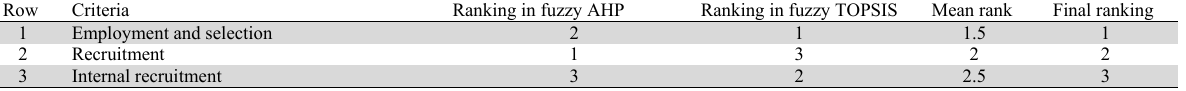
The results of final ranking of main HRM sub-criteria Row Criteria Ranking in fuzzy AHP Ranking in fuzzy TOPSIS Mean rank Forecasting how to match HR demand and supply Forecasting demand for human resource Forecasting the supply of human resource